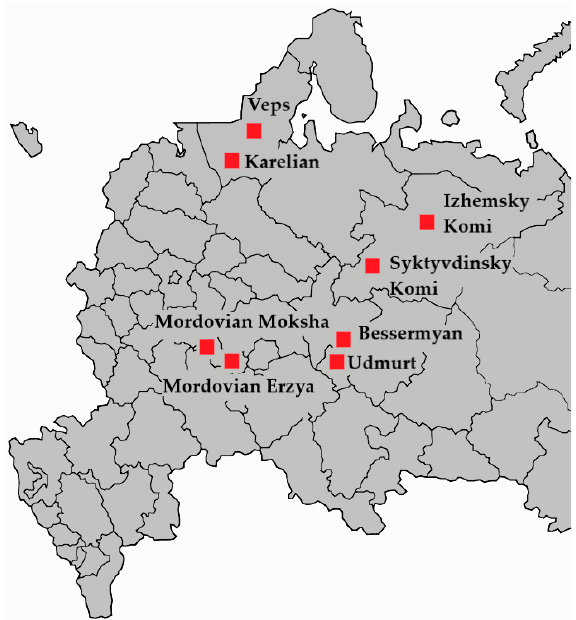
Figure 1. Map of the European part of Russia indicating the places of biomaterial collection. Table 1. Linguistic picture of the Finno-Permic population of Russia, studied in the work, as well as the amount of material